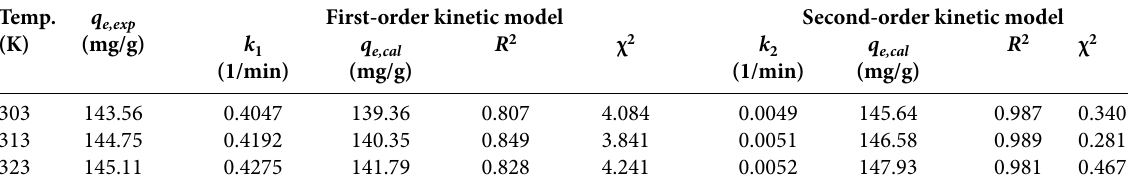
Table 3. Kinetic parameters for MB adsorption by SA-RPB at different temperatures Temp.